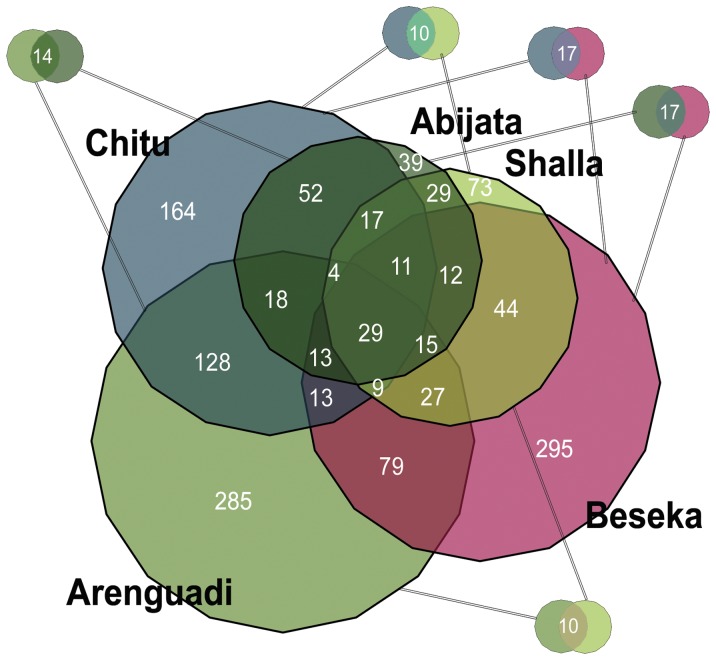
Venn diagram showing the distribution of shared OTUs across lakes.White numbers indicate the number of OTUs in each possible subset, adjusted for differences in sequencing depth.